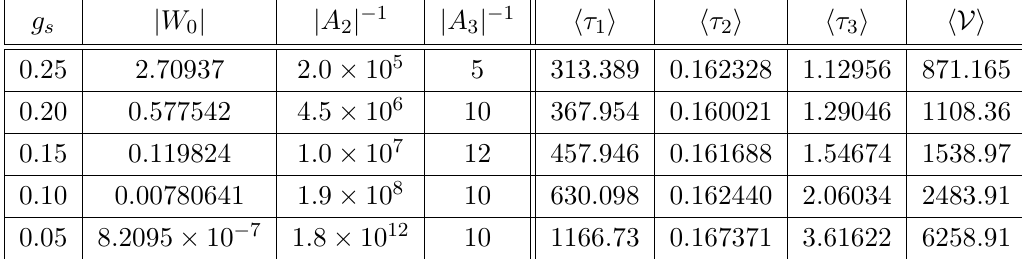
Table 2 . Five choices of parameters g s , all K(cid:127)ahler moduli which reproduce a Minkowski minimum and a viable in(cid:13)ationary